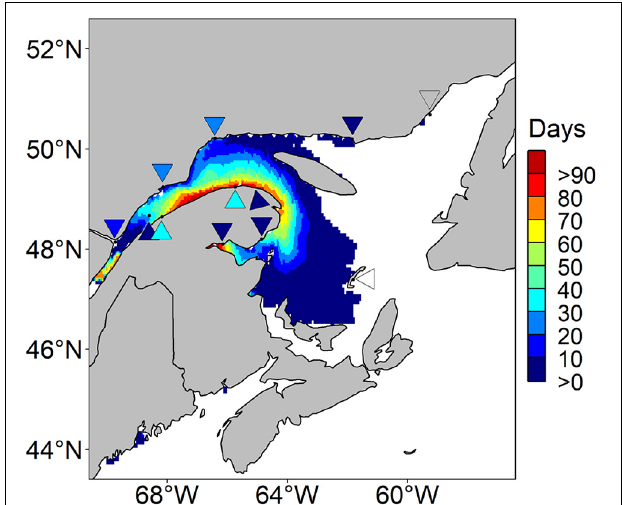
FIGURE 3 | Average number of risk days with Alexandrium catenella ≥ 1000 cells L − 1 from May through October in the Estuary and Gulf of St. Lawrence. Hindcasted risk days (map) and adjusted observed days (reversed triangles) are presented from 1999 through 2008,